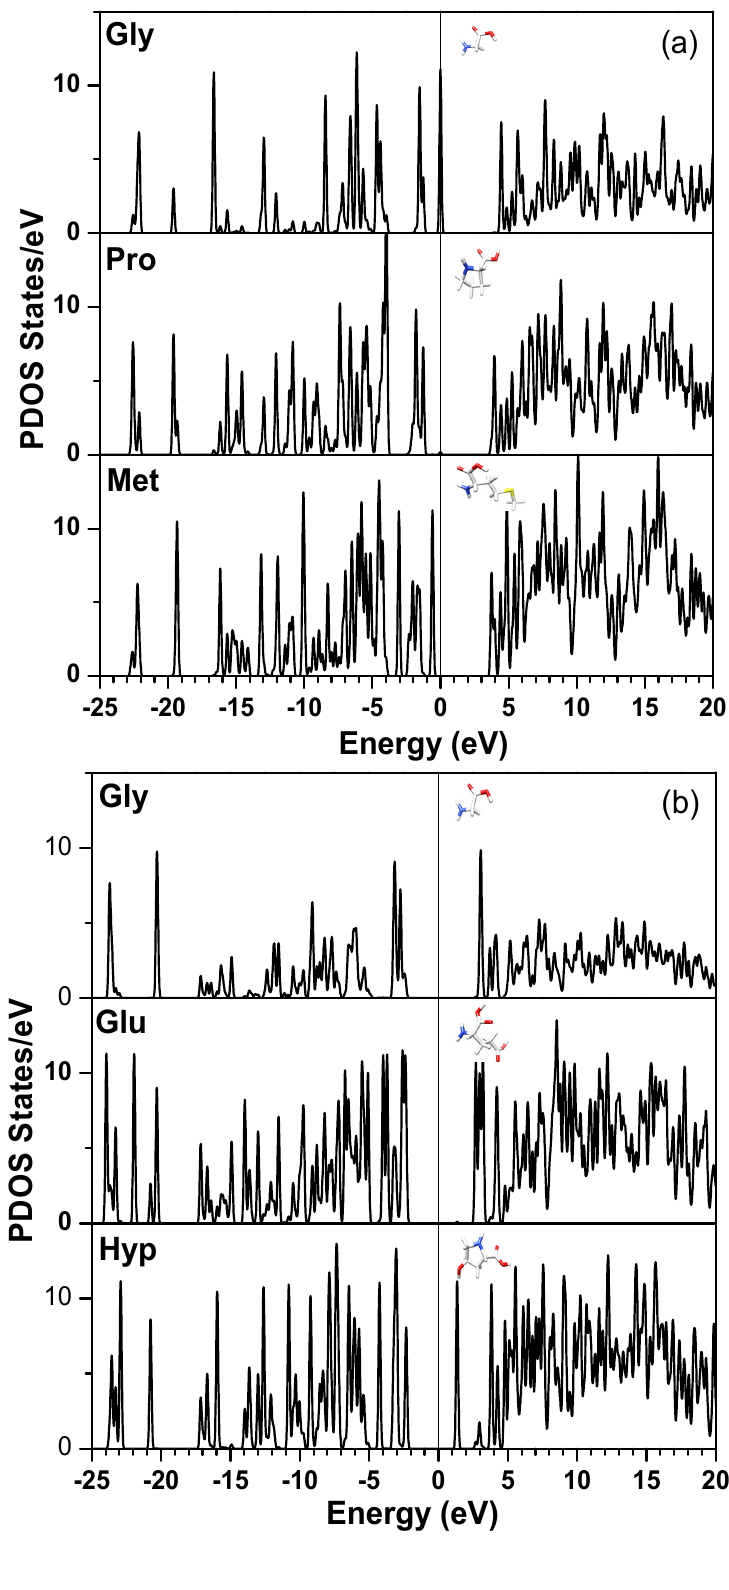
Figure 4. (Color on-line) Calculated PDOS of: ( a ) three amino acids (Gly, Pro, Met) in the first triplet; and ( b ) Three amino acids (Gly, Glu, Hyp) in the last triplet of Figure